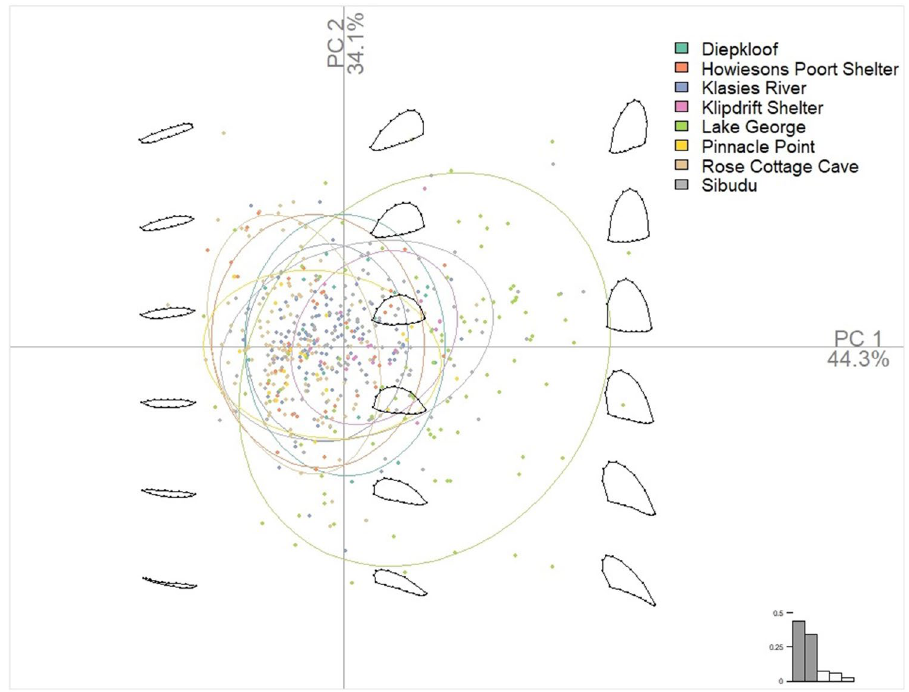
Figure 4. Scatter plot of PC1 and PC1 for the seven southern African and one Australian (Lake George) backed artefact samples with confidence ellipses drawn at the 95% probability level and PCA morphospace shown. This figure was created in RStudio 1.4 www. rstud io. com by